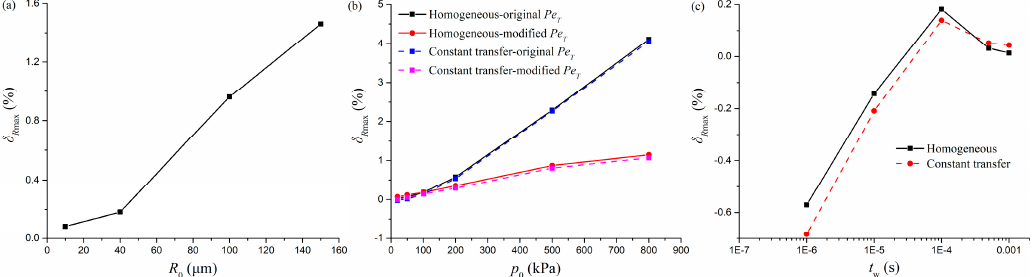
Figure 3. Dependences of δ R max on ( a ) R 0 , ( b ) p 0 , and ( c ) t w based on case D. The differences of R max between the predictions by the homogeneous model and VOF method are small except at large p 0 , and this difference is obviously reduced using modified Pe T .